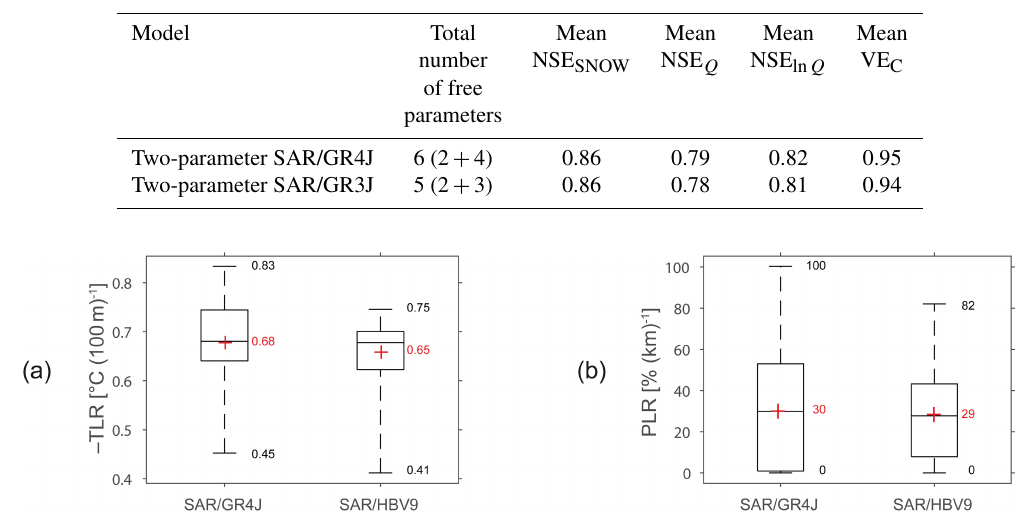
Table 7. Mean validation efficiency on the set of 20 catchments with the GR4J model and the GR3J model in association with the two- parameter SAR.